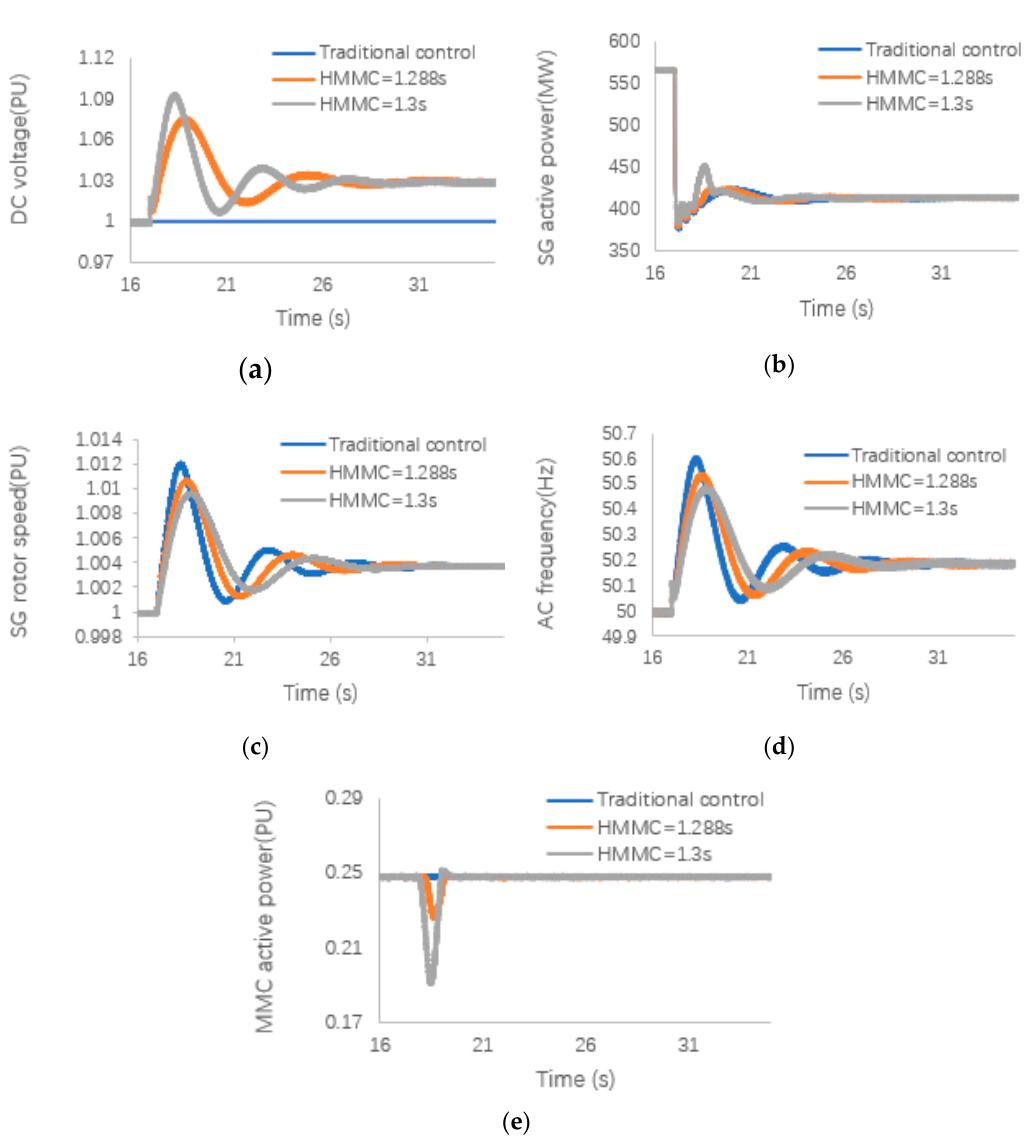
Figure 10. ESCR is 3.5 for 20% load decrease: ( a ) DC voltage; ( b ) SG active power; ( c ) SG rotor speed; ( d ) AC system frequency; ( e ) MMC active power.